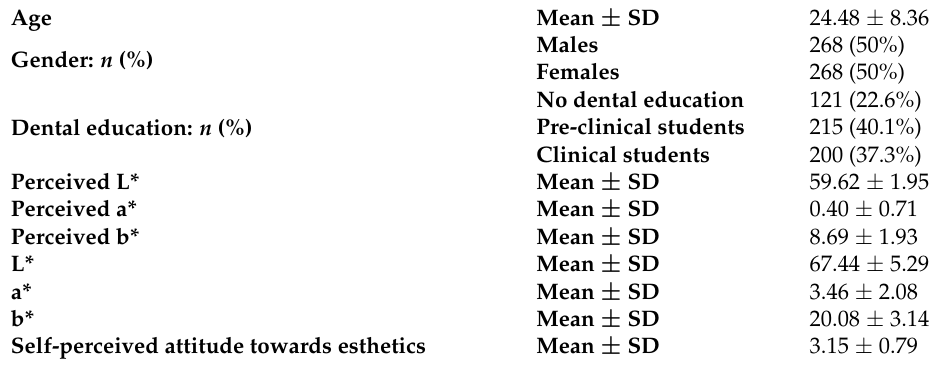
Table 1. Sample characteristics ( n =